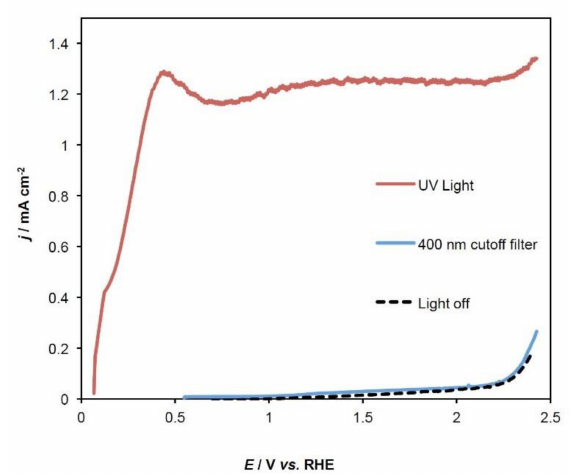
Figure 8. The comparisons of linear scan voltammetry of Ru 4 P 2 -TiO 2 electrodes under UV light illumination, 400 nm cutoff filter, and light off. Conditions: 0.1 M KNO 3 electrolyte, pH 10, adjusted with KOH, 100 mV/s scan rate, 0.13 W/cm 2 UV light power density. Reprinted with permission from [106]. Copyright (2015) American Chemical